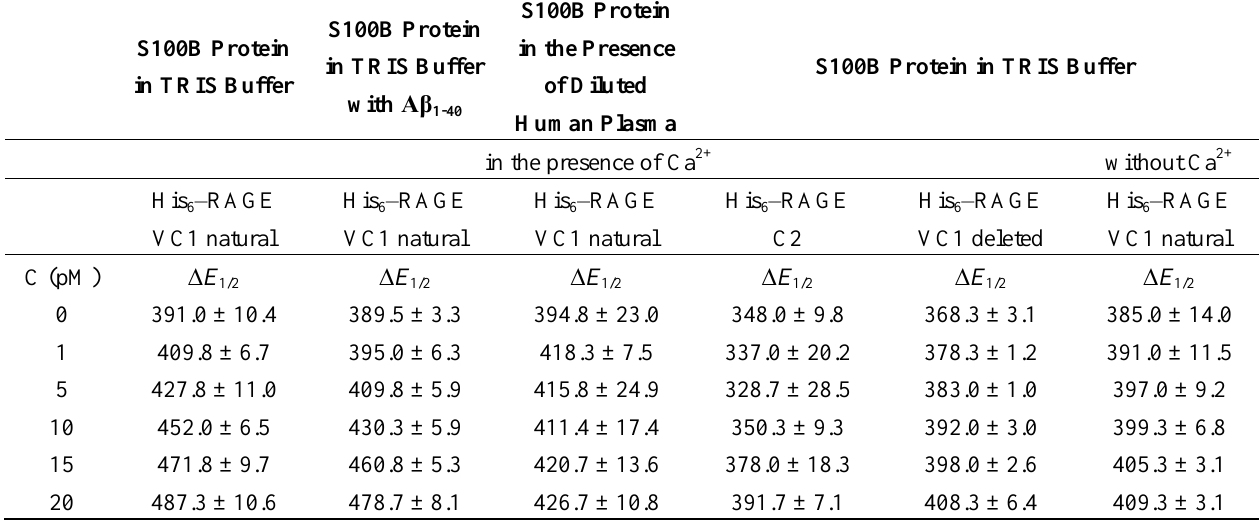
(mV) measured with electrodes incorporated 1/2